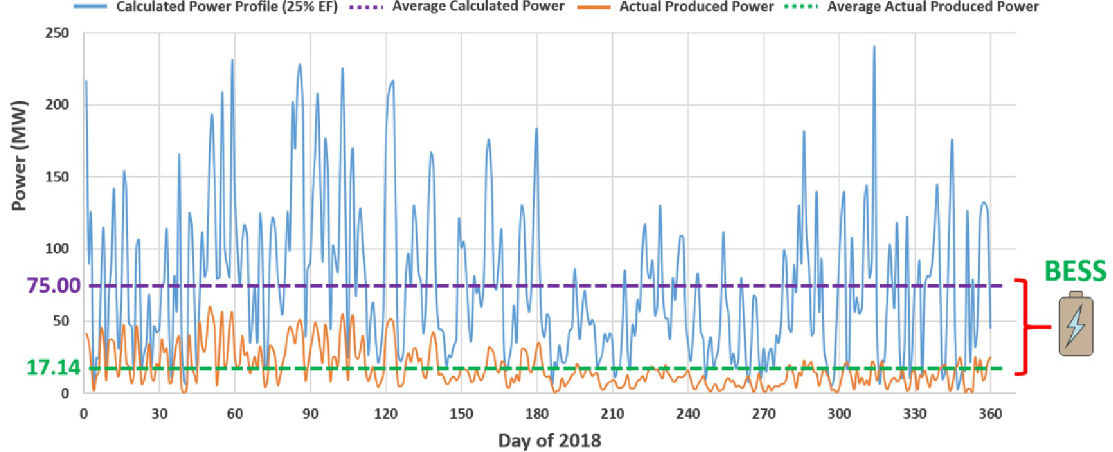
Fig 1. Comparison between actual produced power profile of 250 MW wind farm in Texas, USA in 2018 and calculated power profile assuming 25% efficiency factor for wind turbines.